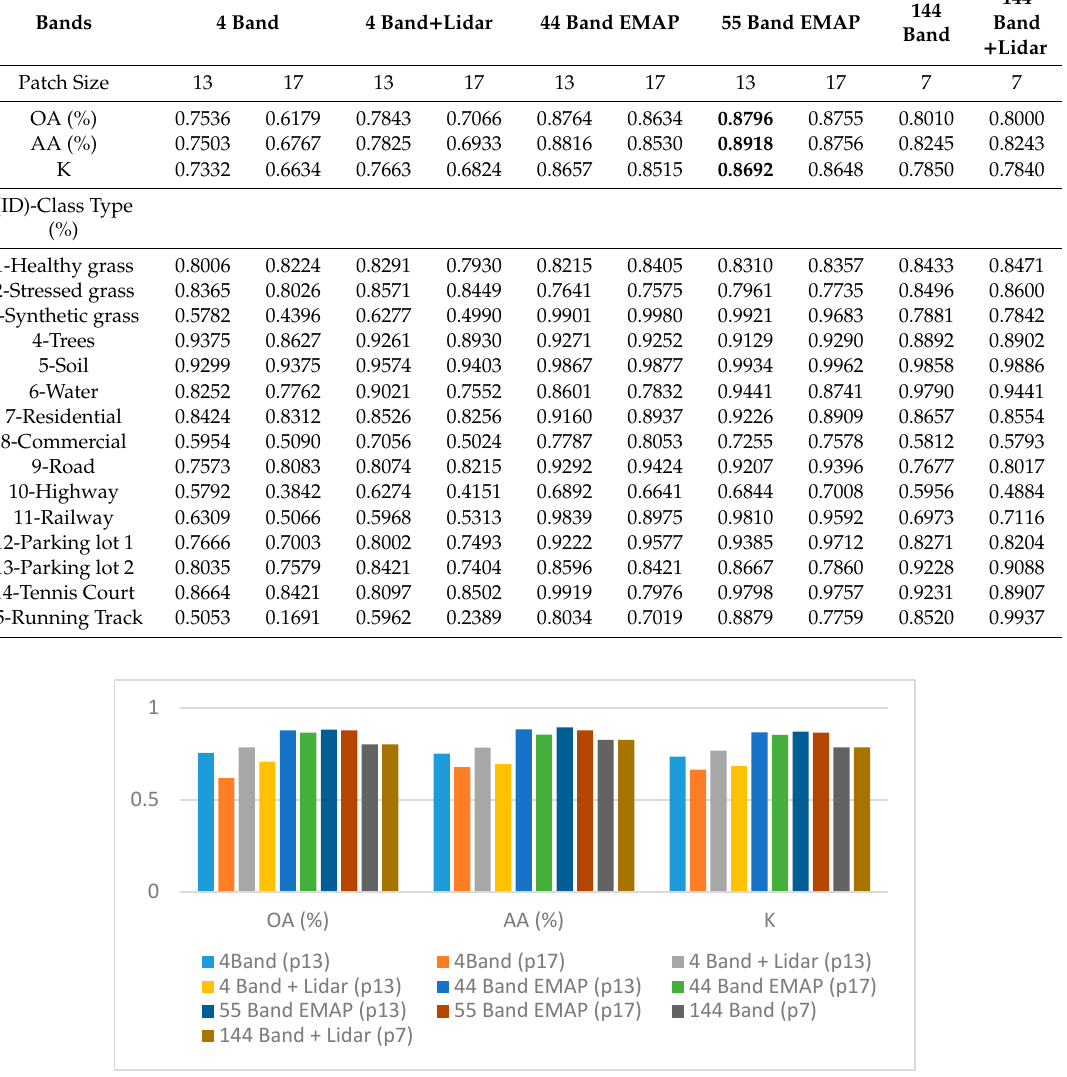
Figure 8. Classification accuracy for each land cover type with CNN-3D model using the investigated band combinations. ( a ) RGB+NIR, four-band; patch size 13 × 13 patch ( b ) RGB+NIR+LiDAR, five-band; patch size 13 × 13 ( c ) 44 EMAP-augmented bands from RGB+NIR; patch size 13 × 13